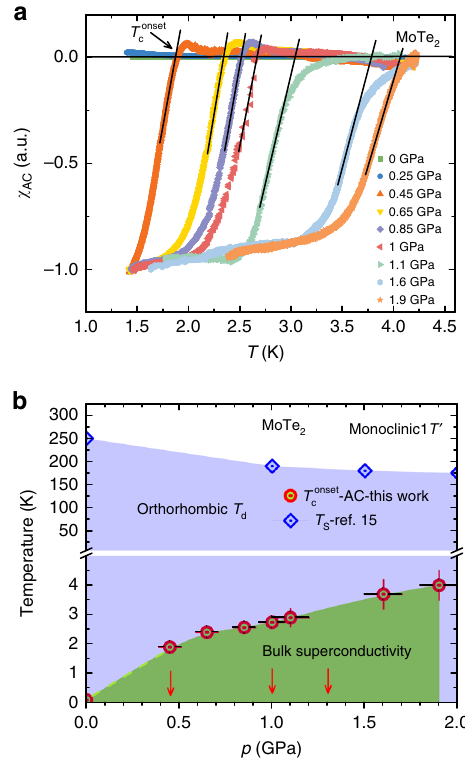
Fig. 1 AC-susceptibility as a function of temperature and pressure in MoTe 2 . a Temperature dependence of the AC-susceptibility χ AC for the polycrystalline sample of MoTe 2 , measured at ambient and various applied hydrostatic pressures up to p ≃ 1 GPa. The arrow denotes the superconducting transition temperature T c . b Pressure dependence of T c (this work) and the structural phase transition temperature T S 15 .